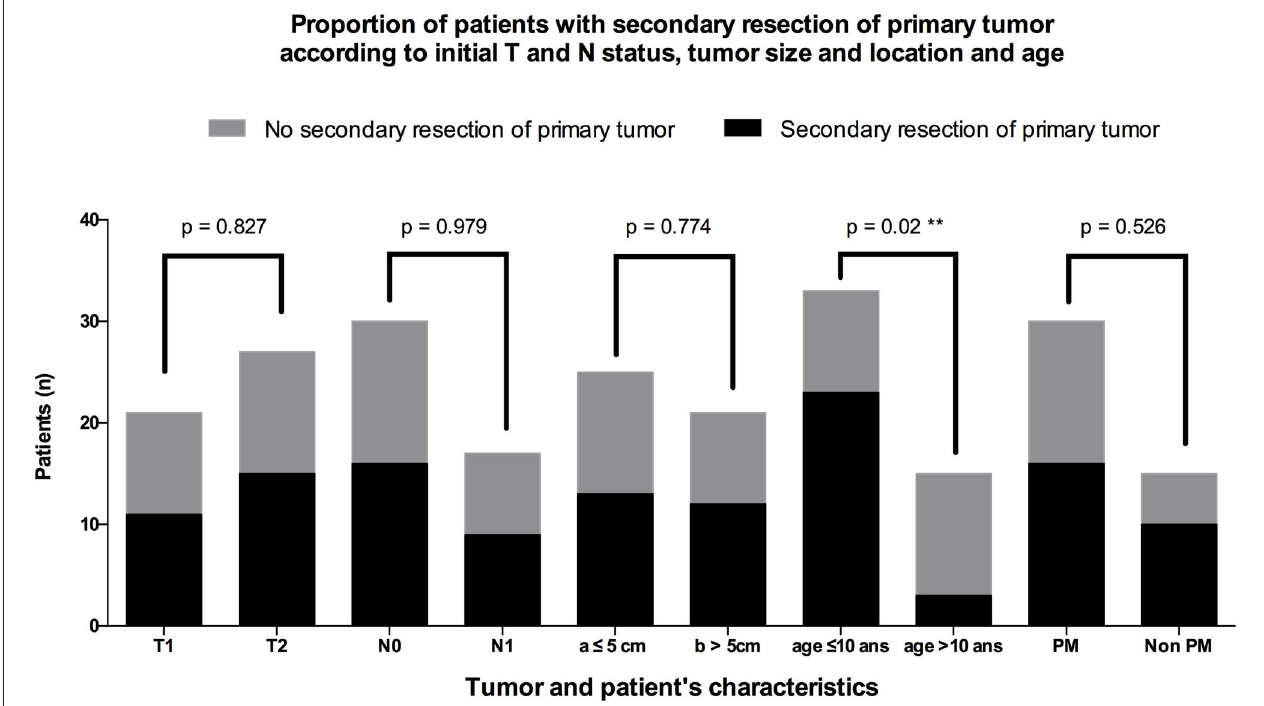
FIGURE 3 | Repartition of operated and non-operated patients according to the initial T and N status, tumor size and location, and patient age.